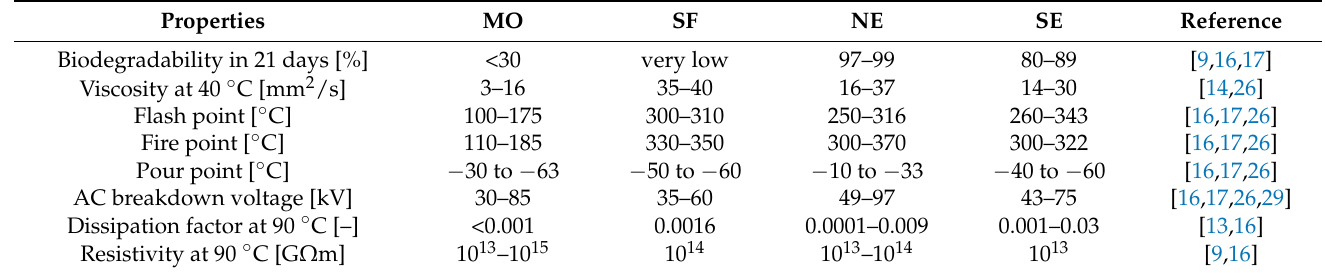
Table 1. Different properties of base